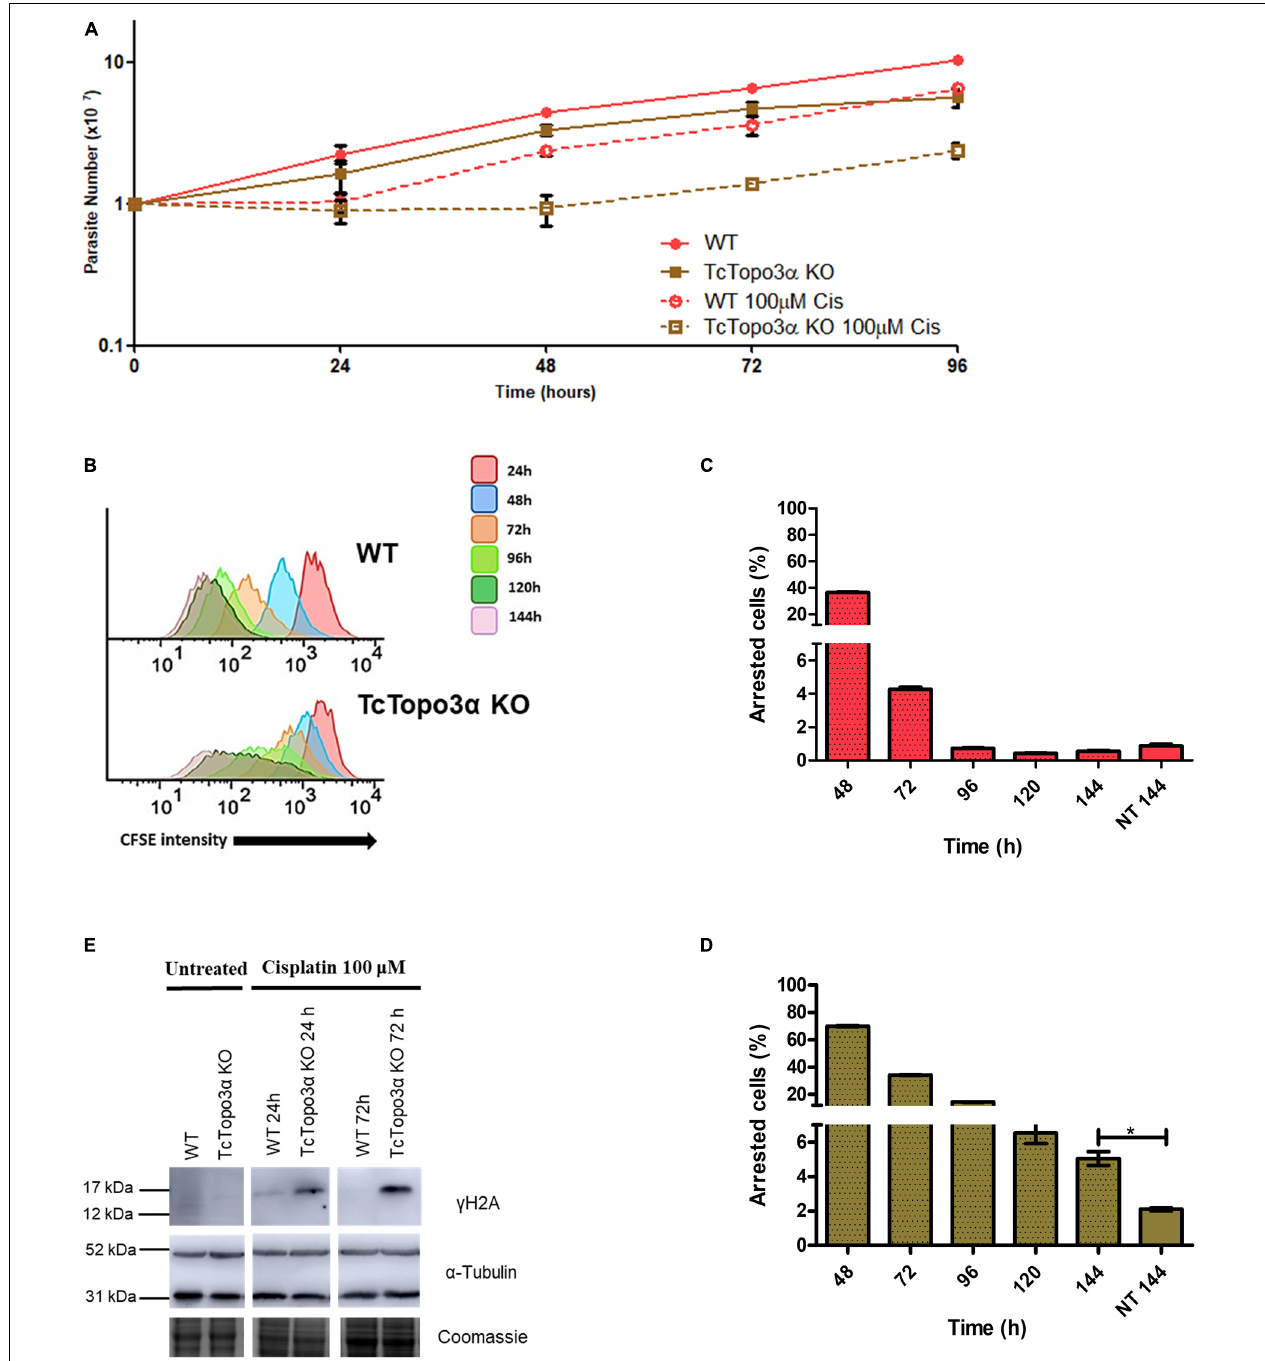
FIGURE 4 | The role of topoisomerase 3 α in the response to cisplatin treatment. (A) Growth curve after the treatment with 100 µ M Cis for 1 h in PBS buffer. After the treatment, the cells were cultivated in fresh medium. The cells were counted every day using a cytometry chamber and vital dye erythrosine. It shows that TcTopo3 α KO cells exposed to Cis delayed the resumption of growth in relation to WT cells. (B) Flow cytometry histograms of epimastigote cultures from each strain. CFSE fluorescence intensity was followed every 24 h until 144 h. Cells that exhibited similar CFSE fluorescence intensity at 144 h when compared with the level of half median at 24 h were considered as dormants. (C,D) Average of dormant cells’ percentages in WT (C) and TcTopo3 α KO (D) cells at 144 h was detected in flow cytometry histograms. Representative results of three distinct experiments in three technical triplicates. Asterisks indicate statistically significant differences among groups ( p -value < 0.05). (E) Western blot to measure the levels on DNA damage after the Cis treatment. The extracts were prepared at the indicated time points and were analyzed by Western blot with anti- γ H2A antibody, a DSB marker. The anti- α -tubulin antibody was used as a loading control.